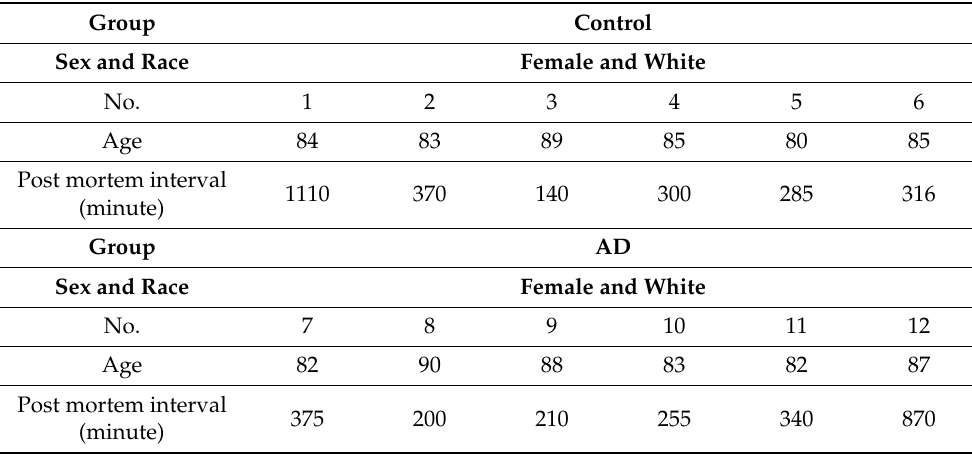
Table 4. The information on the human brain of control and